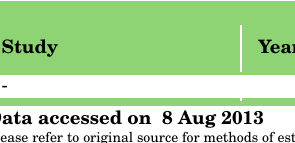
Table 44: Lifetime prevalence of anal intercourse among women in